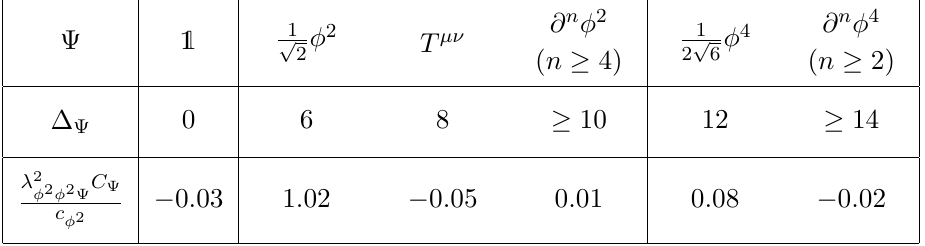
Table 1 . The contribution of all the operators in the (cid:30) 2 (cid:30) 2 OPE to the scale anomaly c eq. (2.23). The second column indicates the disconnected part. The operator (cid:30) 2 itself gives by far the largest contribution to the anomaly. T (cid:22)(cid:23) is the stress-energy tensor for the free scalar theory. The columns denoted @ n (cid:30) 2 and @ n (cid:30) 4 indicate the total contribution of all operators of each